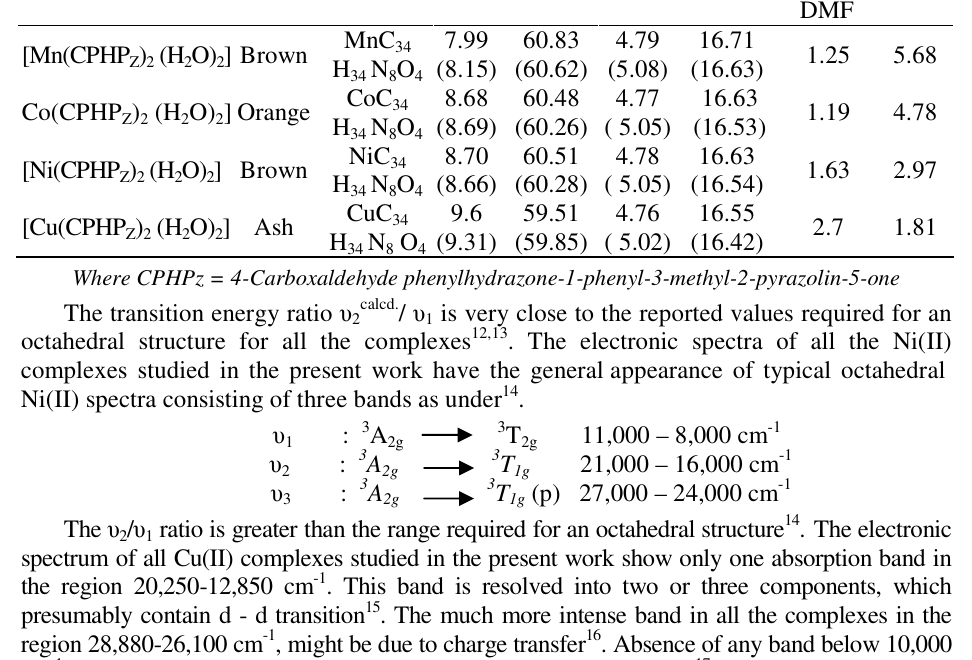
Table 1. Physical and analytical data of metal complexes